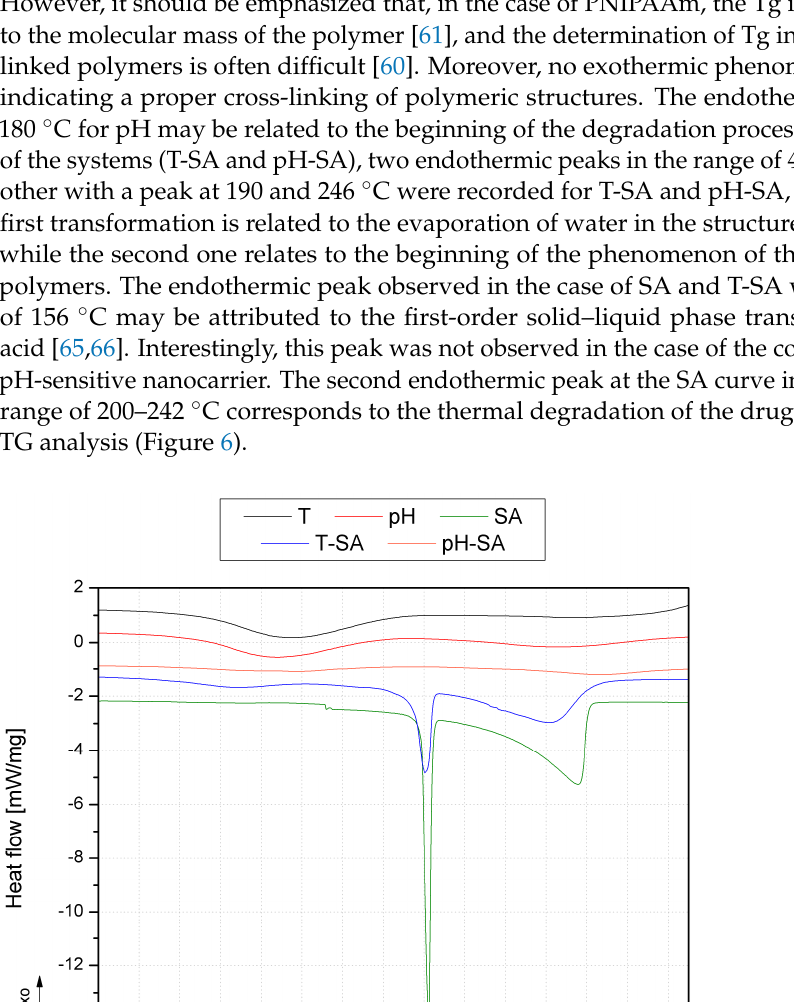
Figure 9. DSC thermograms of the basic matrix (M) and systems with thermo/pH-sensitive nanocar- riers and salicylic acid.